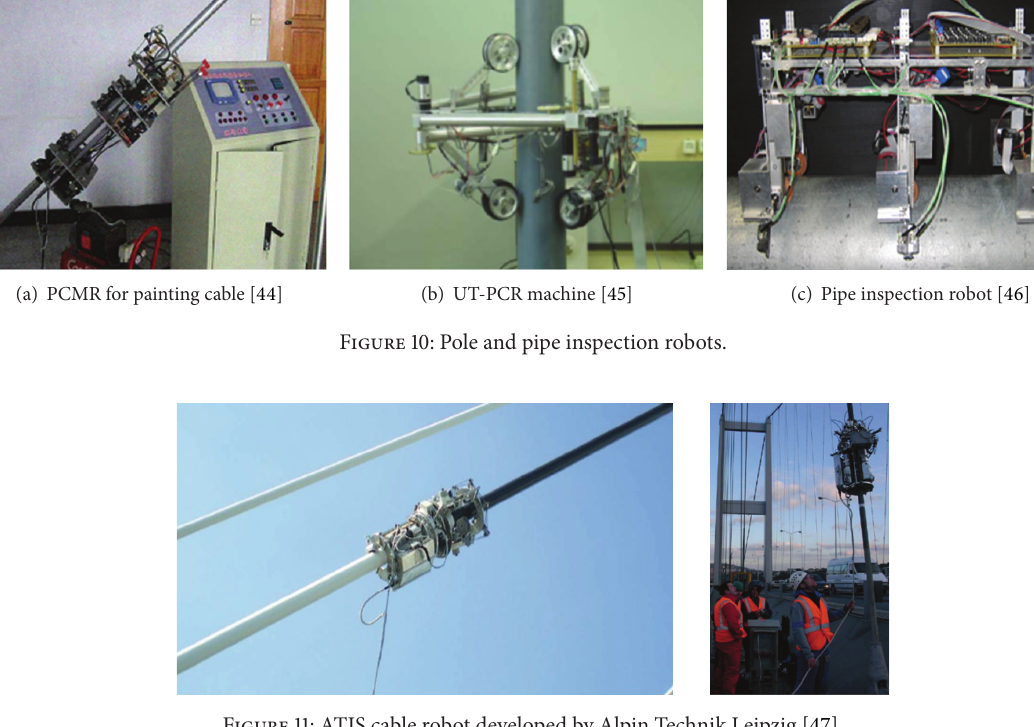
Figure 11: ATIS cable robot developed by Alpin Technik Leipzig